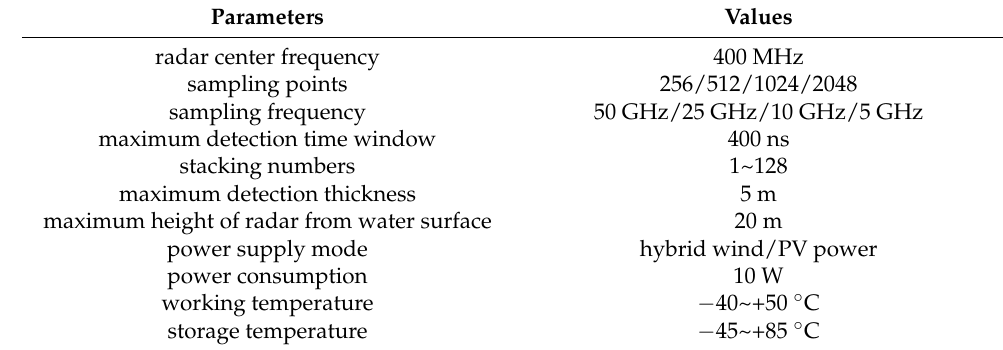
Table 1. Technical parameters of